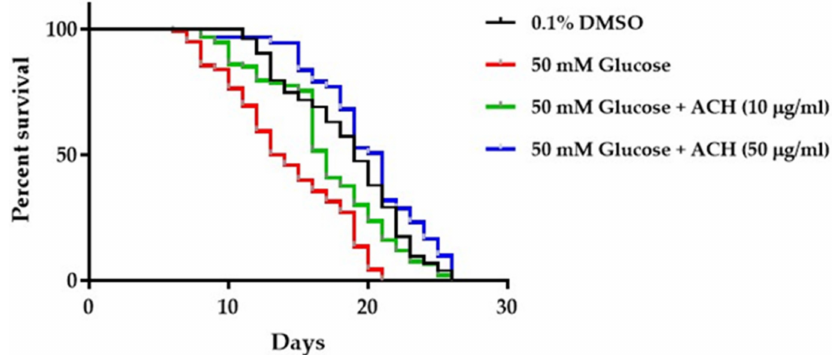
Figure 6. The effect of high glucose and ACH crude extracts on C. elegans lifespan.